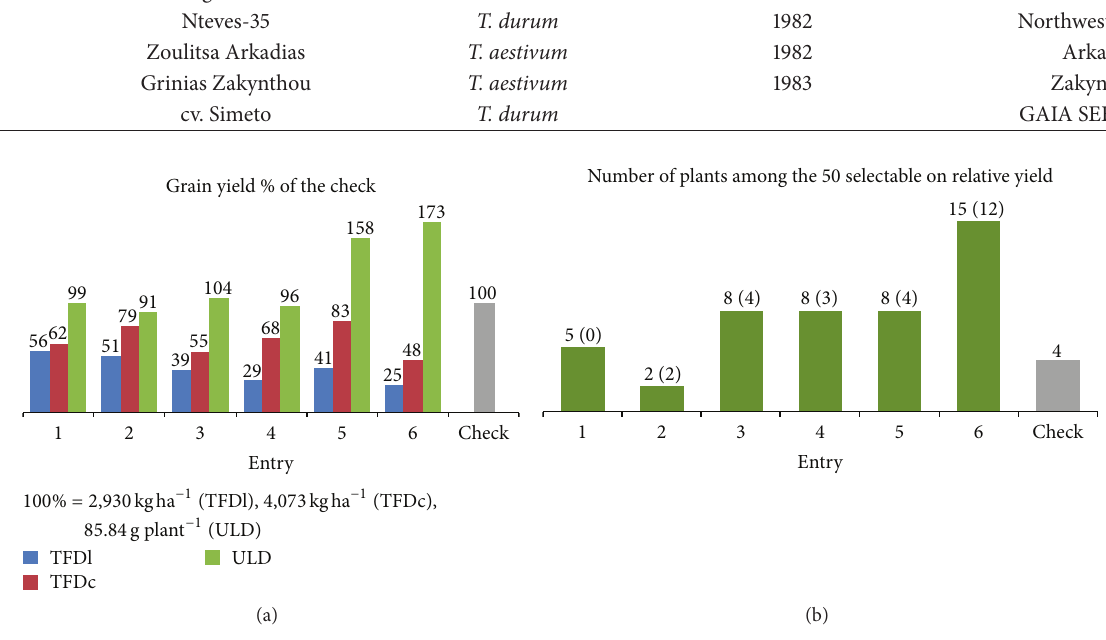
Figure 2: (a) Yield performance of the six landraces (1–6) and the check cultivar at the typical farming density under the low-input (TFDl) and conventional regime (TFDc), as well as at the ultralow density (ULD). (b) The number of selectable plants of each genotype on the relative yield at the ULD (in parenthesis the number of plants exceeding the highest check relative yield).